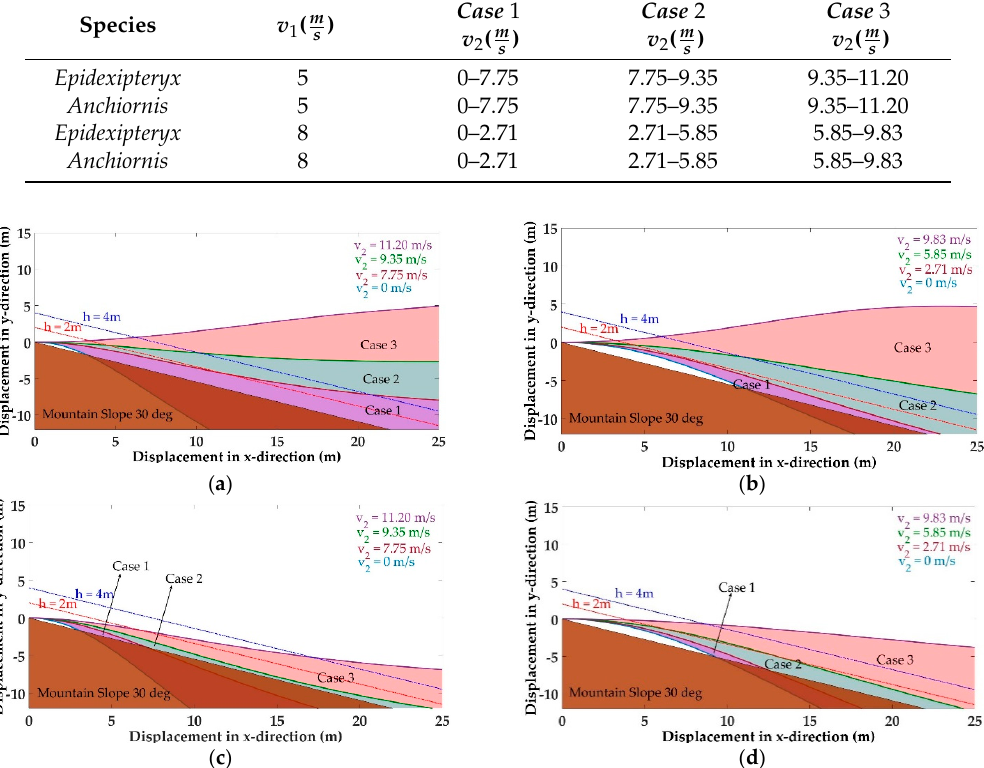
Figure 7. Trajectories of Anchiornis running at a speed of: ( a ) 5 m/s; and ( b ) 8 m/s; Trajectories of Epidexipteryx running at a speed of: ( c ) 5 m/s; and ( d ) 8 m/s.